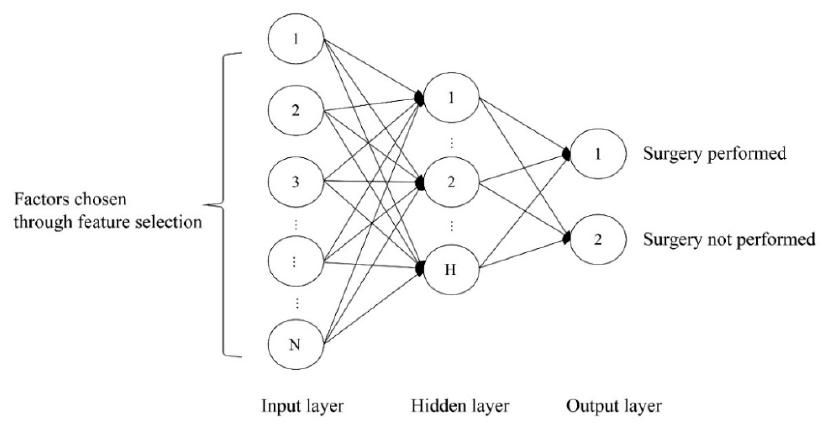
Figure 2. Feature selection and backpropagation neural network.